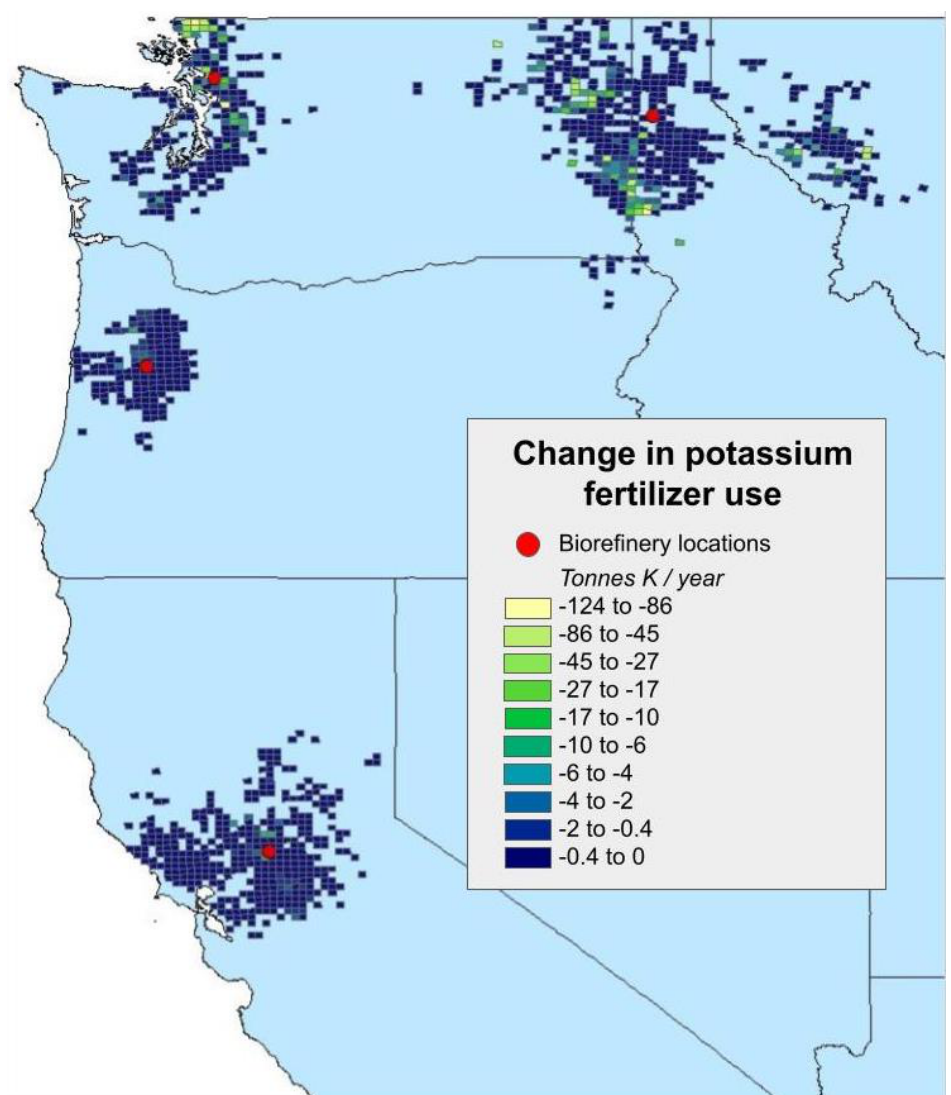
Figure 4. Change in potassium fertilizer use for each pixel as a result of switching from current practices to growing poplar trees for bio-jet fuel production. Potassium fertilizer is not expected to be used to grow poplar trees, and therefore all pixels would see a decrease in use. Pixels that contain crops where potassium fertilizer is used would see the greatest reduction in use (light blue/green to yellow). Pixels that predominantly contain rangeland that would be converted would see very little reduction in phosphorus use (dark blue).